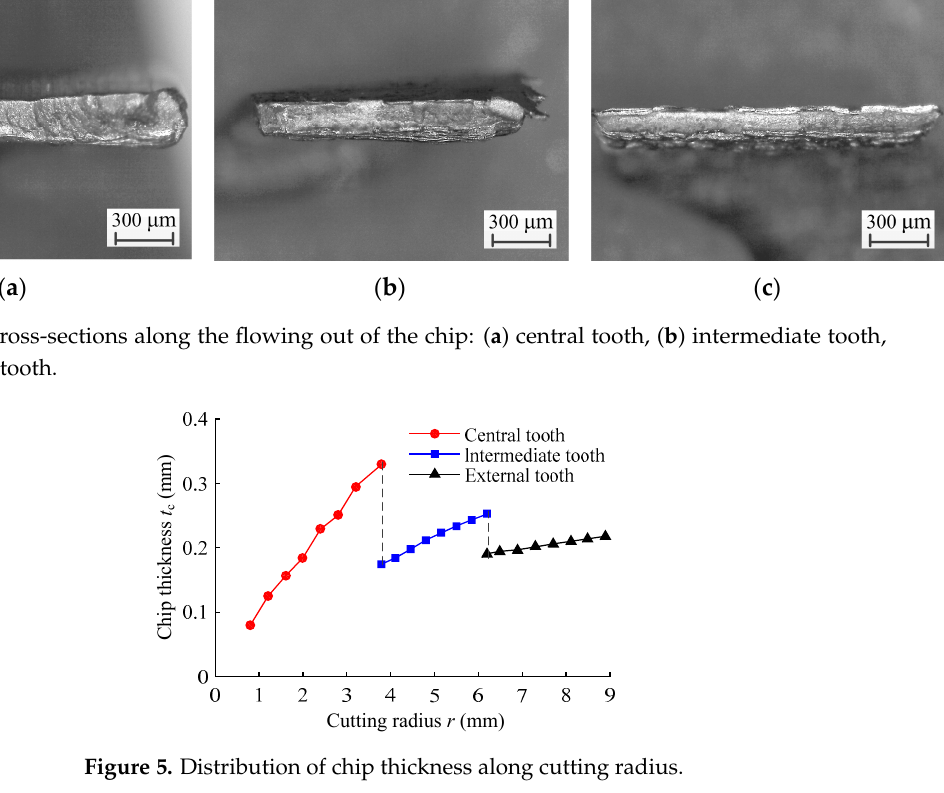
Table 2. Chip breaker geometric parameters of the staggered teeth BTA drill.